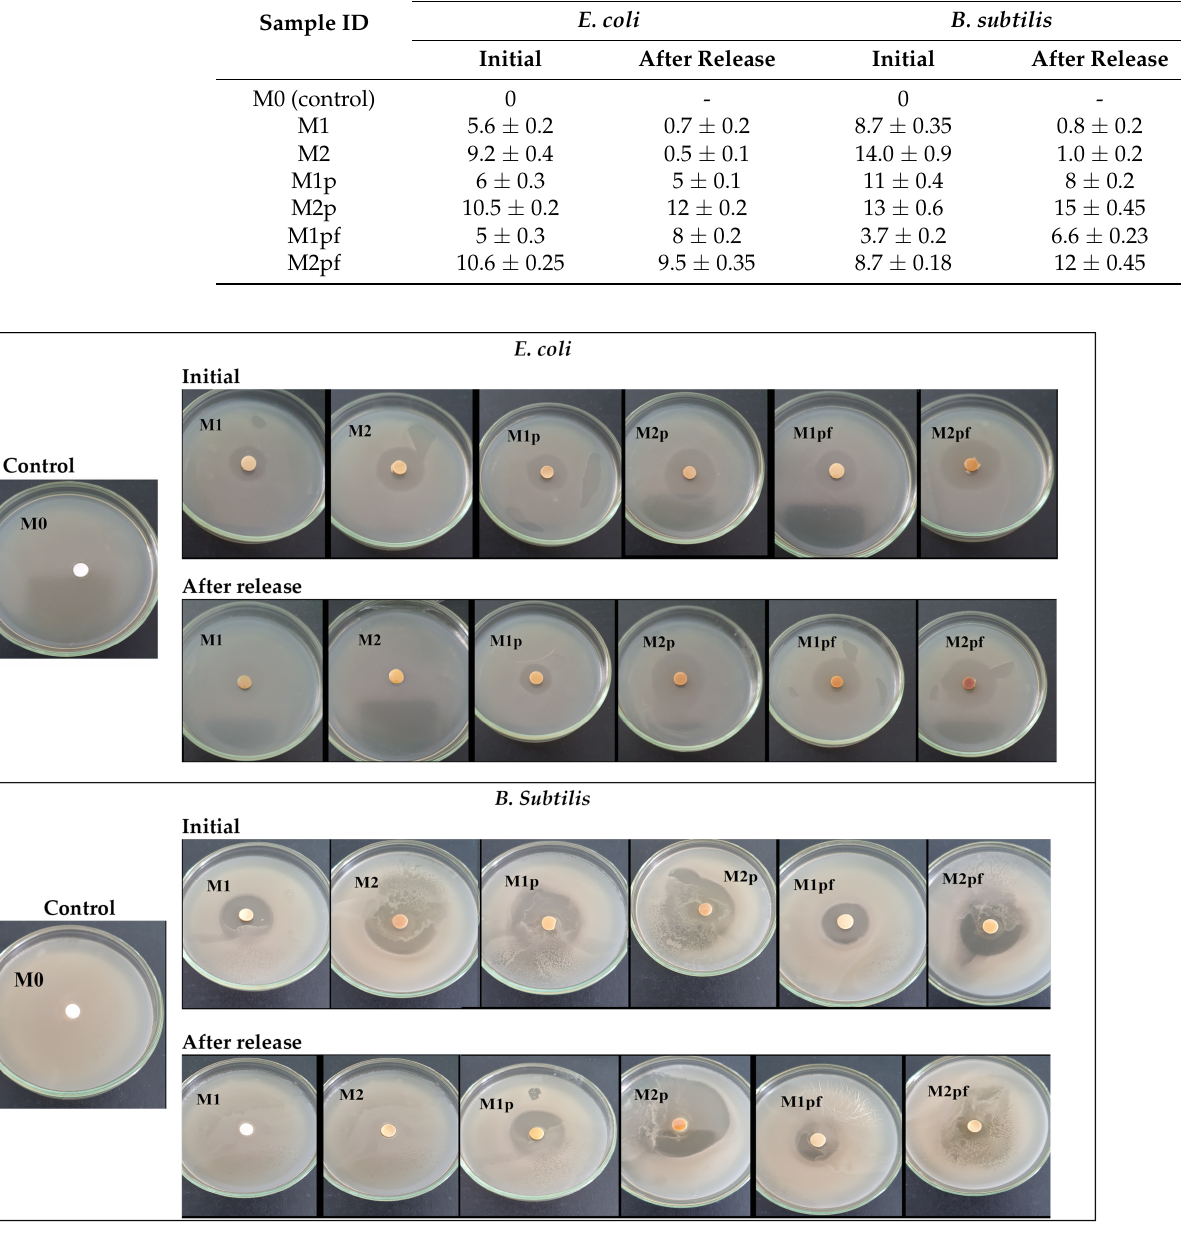
Figure 4. Antimicrobial activity against E. coli and B. subtilis